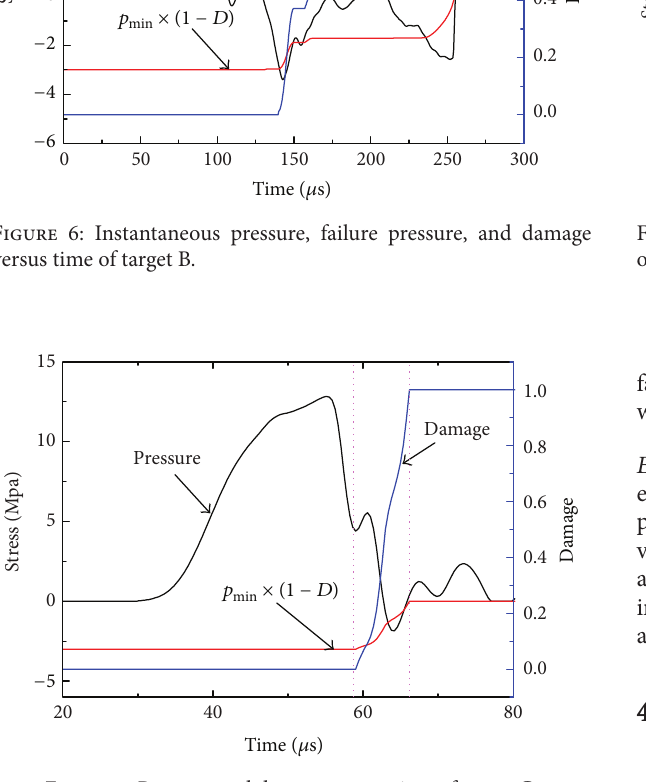
in the entire blast event.